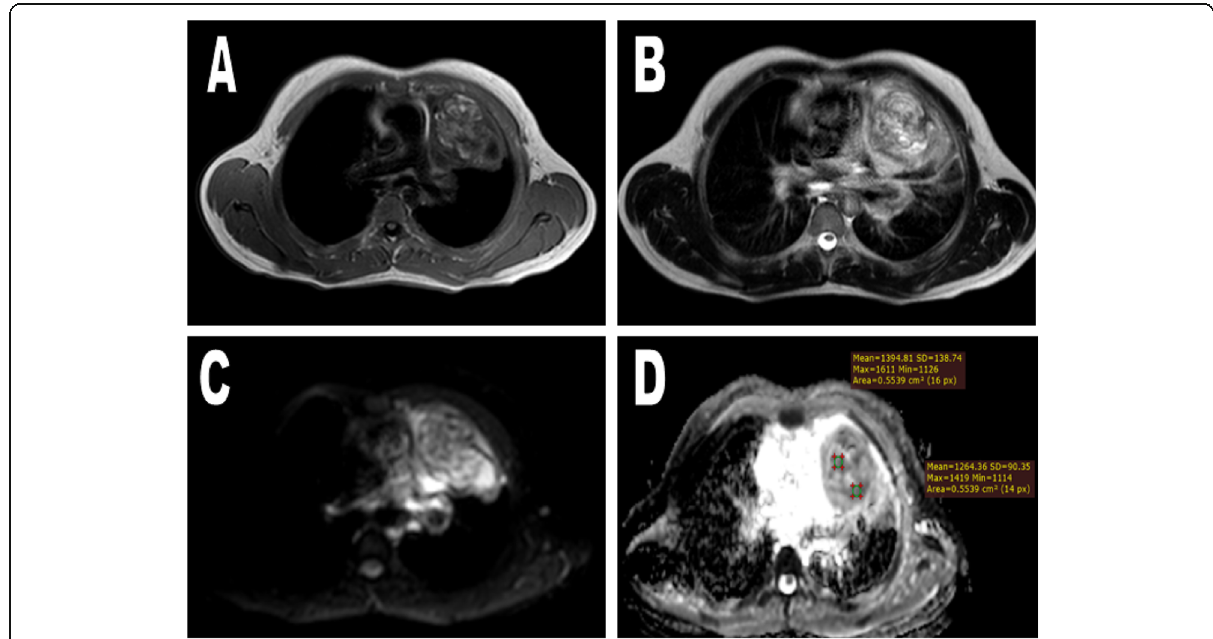
Fig. 5 Case of teratoma. A 14-year-old male patient presenting with dyspnea. ( a ) axial T1WI, ( b ) axial T2WI, ( c ) DWI, ( d ) ADC map showing mediastinal soft tissue mass showing heterogeneous signal intensity in T1 and T2WI, isointense to slightly faint high signal in DWI and mixed signals in ADC map. The mean ADC is 1.3 × 10 − 3 mm 2